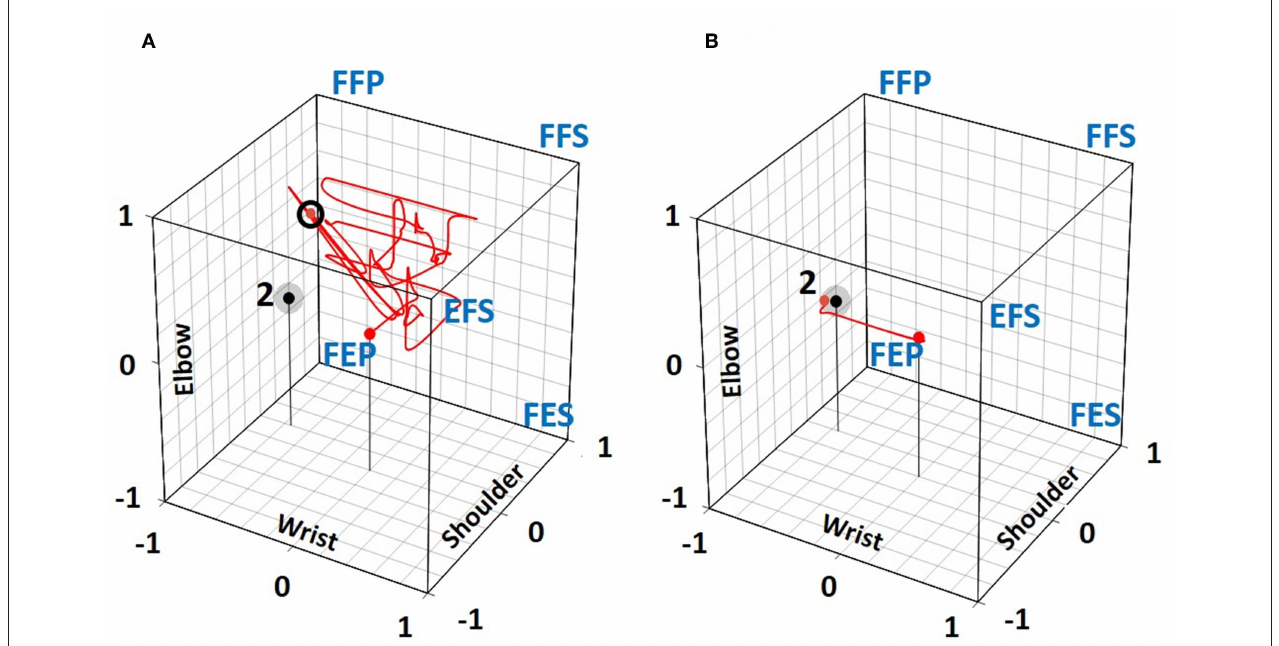
FIGURE 6 | Trajectories taken by S3 to move the red sphere toward target 2 in the 5 SP condition. (A) An unsuccessful 1st trial in spite of 72 posture changes where the final red sphere position after 120s was at a distance of 0.68 (small black circle) from the target. (B) In the 3rd trial, the target was reached within 9s with only 4 posture